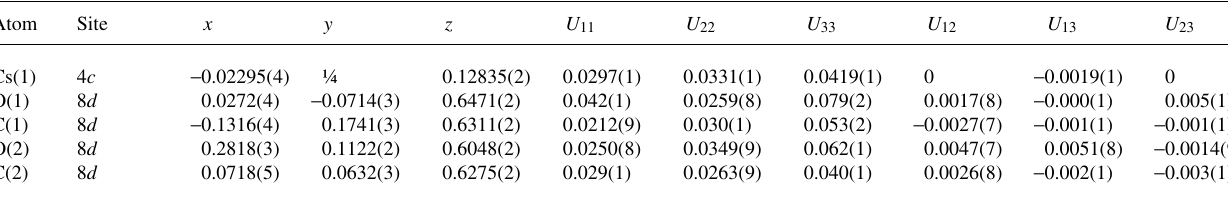
Table 3. Atomic coordinates and displacement parameters (in Å 2 )